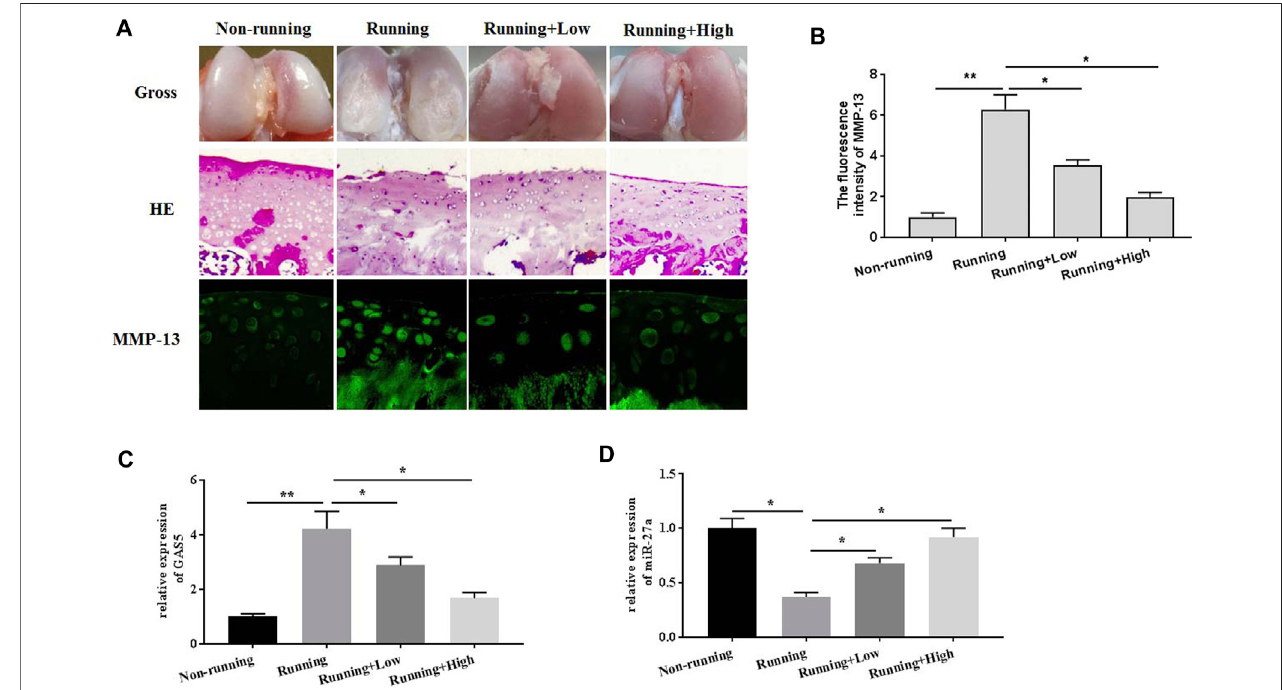
FIGURE 1 | The effects of XH on mechanical stimulation-induced OA cartilage in mice were investigated. (A) The gross observation, histochemical examination, andimmuno fl uorescenceactivityofMMP-13wereindicated(magni fi cation × 40). (B) Thecalculationof fl uorescenceactivityofMMP-13.TheexpressionofGAS5 (C) and miR-27a (D) inthekneejointcartilagesweredetectedbyqRT-PCR.* p < 0.05and** p < 0.01.Low,thegrouptreatedwithXH(30 mg/kg/d);High,thegrouptreatedwith XH (60 mg/kg/d).